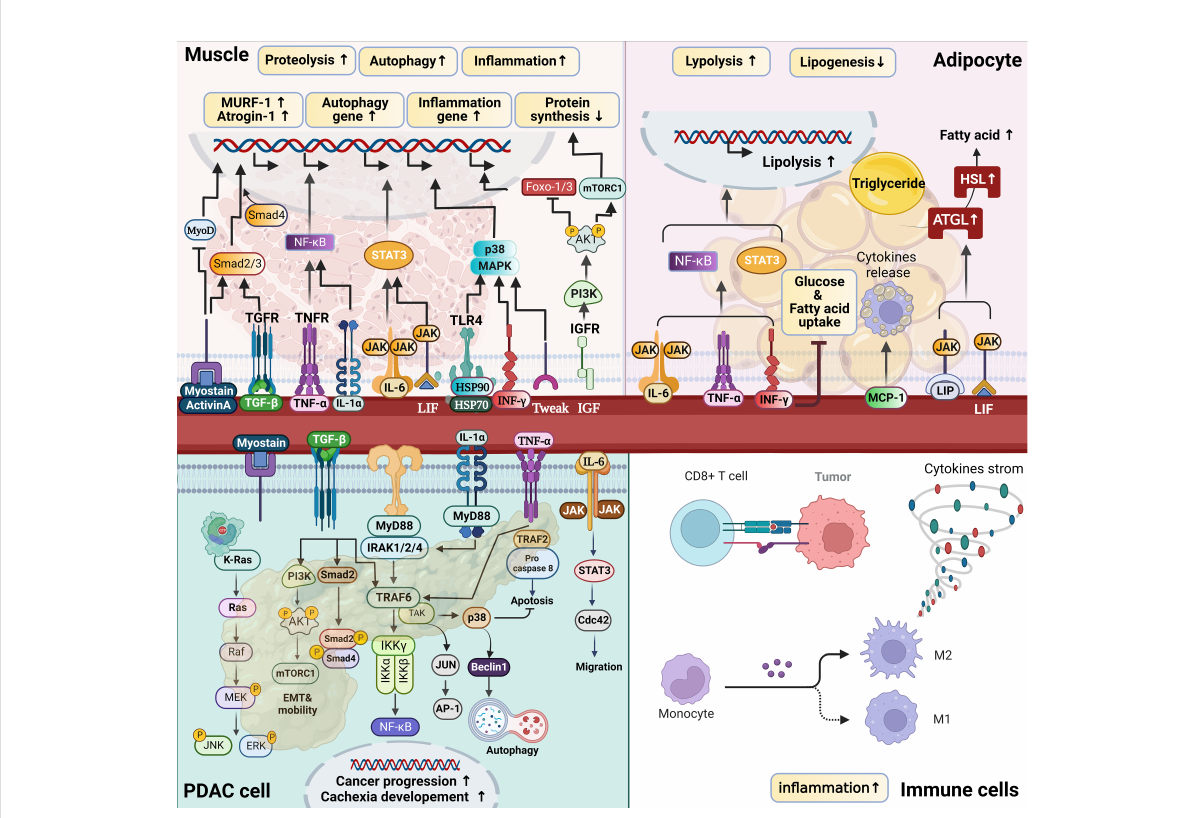
FIGURE 5 Pro-cachectic mediators of catabolism in PDAC-CC. Cachexia signals induce tissue catabolism by modulating gene expression pro fi les related to protein synthesis and degradation in muscle, lipid depletion, and tumor progression, primarily via the nuclear factor kappa B (NF- k B) and Janus kinase (JAK) – signal transducer and activator of transcription (STAT) pathways. In tumors, multiple receptors, including the Toll-like/IL1 receptors (TIRs), tumor necrosis factor (TNF), transforming growth factor-beta (TGF- b ), and interleukin receptors (IL-6R being the best-studied), utilize overlapping and distinct signal transduction mechanisms to affect cellular outcomes, including increased cytokine production, proliferation, survival, migration, autophagy, and resistance to chemotherapy and immune surveillance. In addition to cytokines in tumors, circulating cytokines affect muscle and adipocytes, resulting in various metabolic alterations. For example, myostatin/activin A binds to type II receptors (ActRIIB), leading to Smad2/3 phosphorylation and the recruitment of Smad4, which results in muscle wasting. Simultaneously, myostatin/activin A signaling inhibits AKT activity and suppresses FoxOs phosphorylation, activating the ubiquitin – proteasome and autophagy – lysosome systems. IL6 binds to receptors to activate JAK/STAT3 signaling, increasing protein degradation. TNF a and IL1 signaling activates the I k B kinase (IKK) – NF- k B axis to initiate proteasome-mediated protein degradation. Higher levels of tumoral and stromal IL-1 b expression result in a feedback circuit that attributes to cancer progression and cachexia